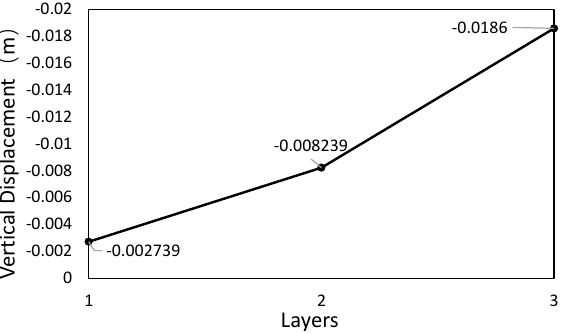
Figure 4. Vertical displacement values of monitoring point.